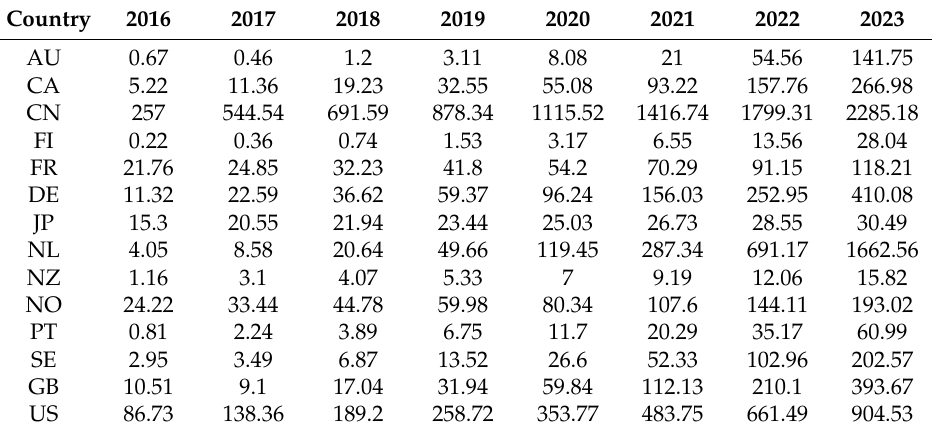
Table 7. The forecasted values of BECS.